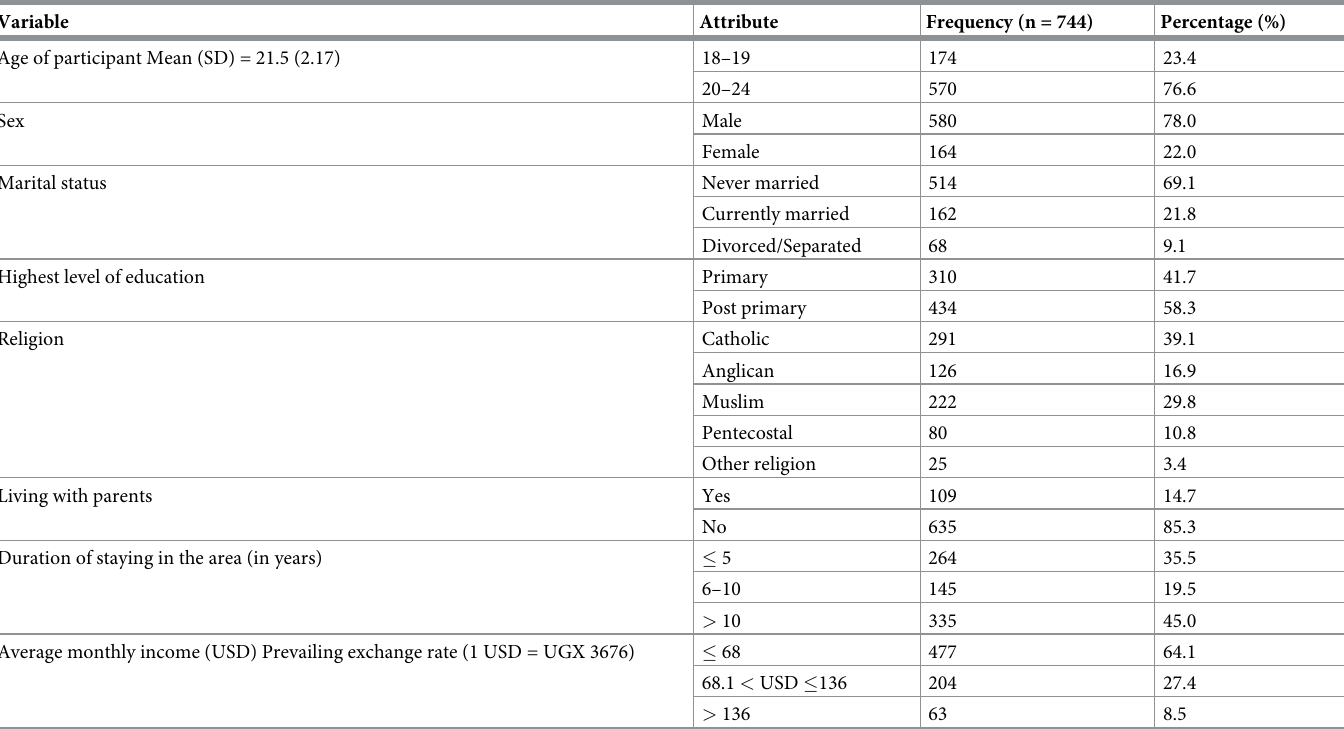
Table 1. Social demographic characteristics of sexually active young-psychoactive-substance users.